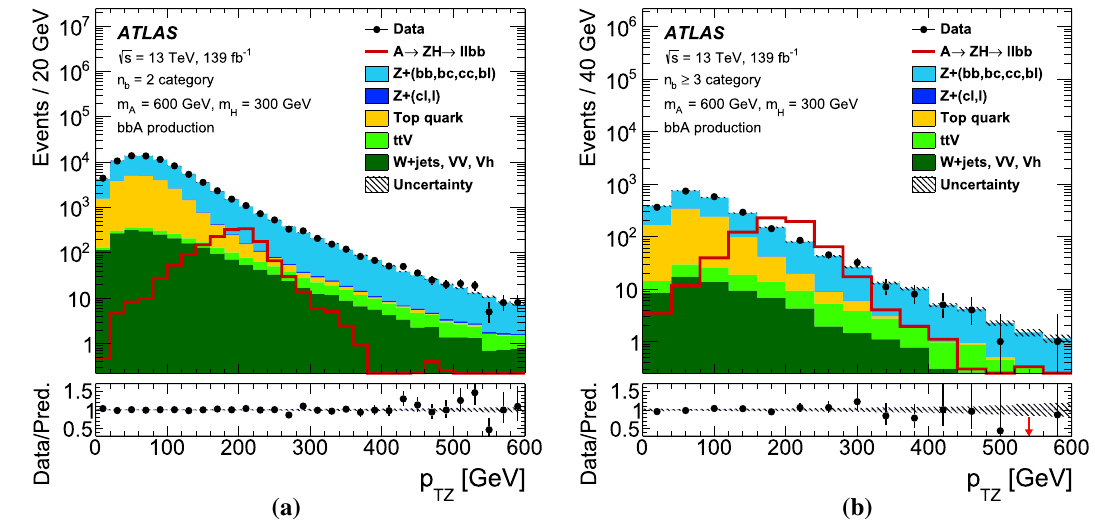
Fig. 3 The p distributions for a the n b = 2 and b the n b ≥ 3 category. The events are required to satisfy all the signal region criteria with the TZ exception of the m bb window requirement. The same conventions as in Fig. 2 are